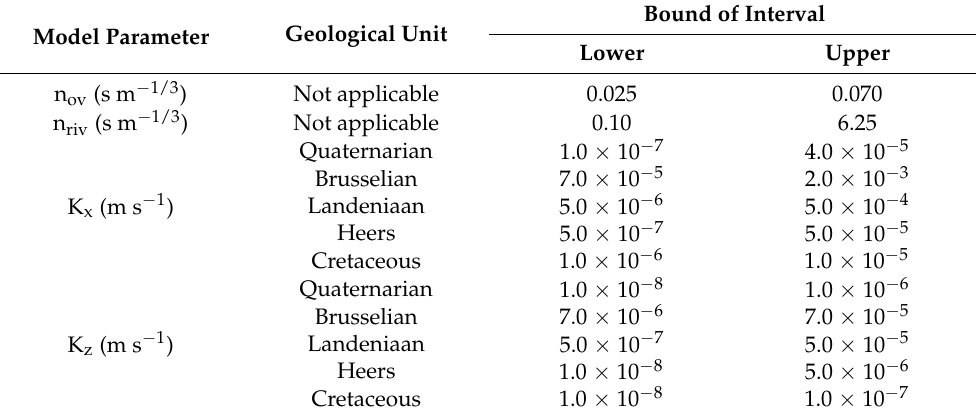
Table 1. Intervals of the calibration process (water routing related)